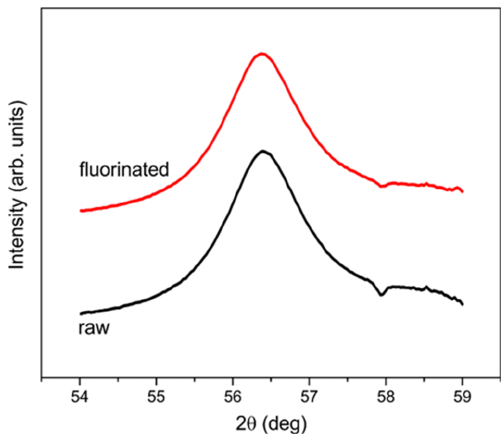
Figure 7. Powder diffraction for DND (black lower line) and F-DND (red upper line, shifted in intensity for better visibility) samples in the proximity of a 422 Debye-Scherrer ring. Full width at half maximum (FWHM) from the Lorentz line shape fit were evaluated to 1.343 ± 0.018 and 1.354 ± 0.022 for DND and F-DND samples, respectively, therefore coinciding. The mean size of DND cores is 4.3 nm.